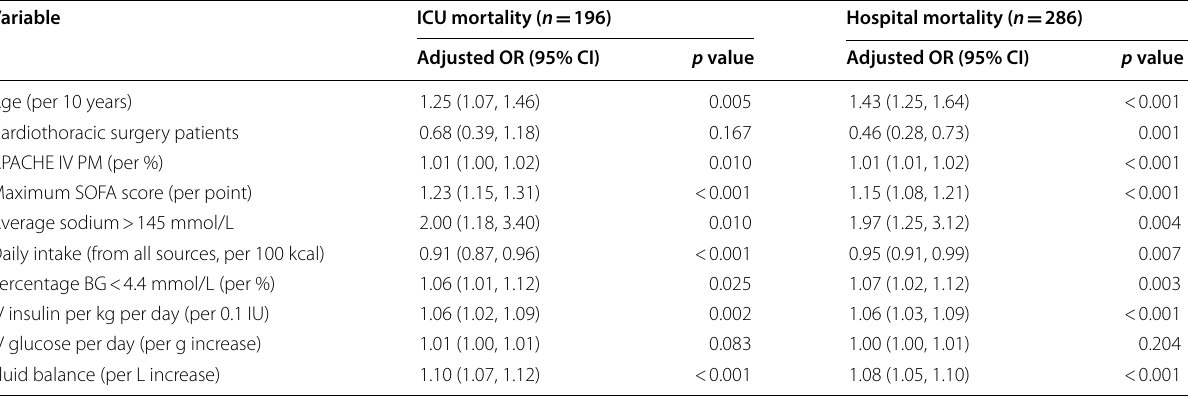
Table 5 Multivariate logistic regression analysis for the association with ICU and hospital mortality in the cohort of patients admitted > 72 h ( n 1550) =